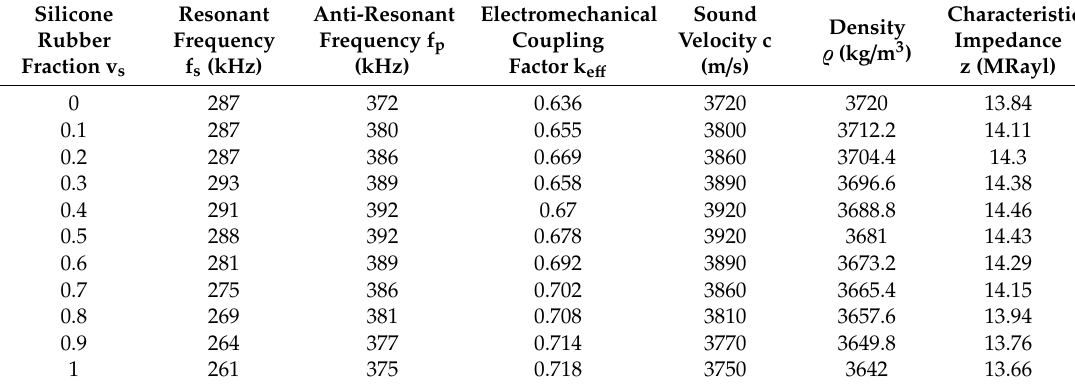
Table 3. Simulation data with different v s (v c = 0.4).